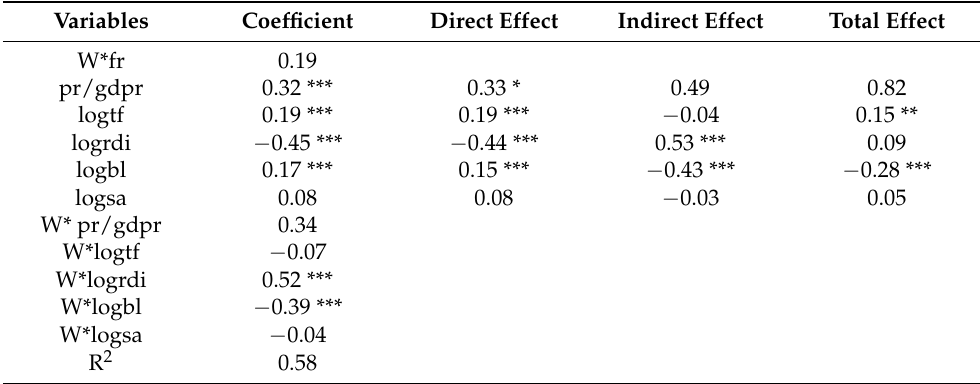
Table 11. Results of the SDM with spatial fixed effects for the western region in China.